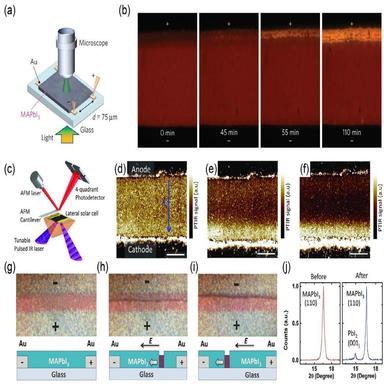
(a) Illustration of the set-up used for in situ monitoring of the poling process using a lateral structure device. (b) Snapshots of the in situ recorded video during the poling process. Copyright 2015, Springer Nature Limited. (c) Illustration of the PTIR measurement. PTIR images of MA+ obtained before (d), after 100 s (e) and after 200 s (f) electrical poling, respectively. Copyright 2015, Wiley-VCH GmbH. (g–i) Optical images and cross-sectional illustrations of the lateral MAPb